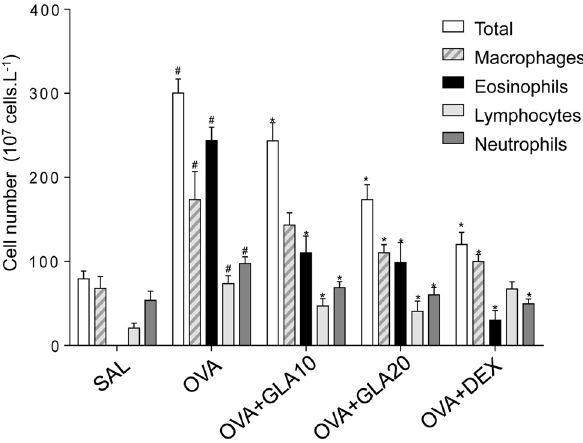
Figure 4: E ff ects of GLA on in fl ammatory cell counts in BALF. The numbers of total in fl ammatory cells, macrophages, lymphocytes, eosinophils, and neutrophils were counted in the BALF in the SAL, OVA - sensitized, Dex ( 1 mg/kg ) , and 10 and 20 mg/kg GLA groups. Compared with the SAL group, # P < 0.05; and compared with the OVA - sensitized group, * P < 0.05. N = 3; analyzed by ANOVA.